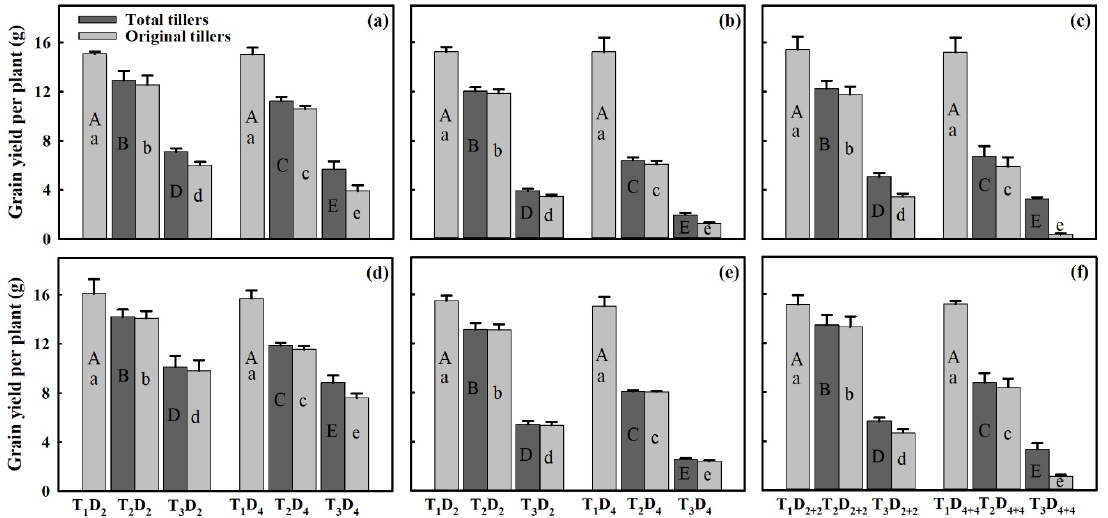
Figure 2. Effects of different high ‐ temperature levels treatments on grain yield per plant including total (original and regenerated tillers) and original tillers of Huaidao ‐ 5 and Wuyunjing ‐ 24 at booting (BT), flowering (FL), and combined (BT + FL) stages. ( a ) Huaidao ‐ 5 at BT treatment; ( b ) Huaidao ‐ 5 at FL treatment; ( c ) Huaidao ‐ 5 at BT + FL treatment; ( d ) Wuyunjing ‐ 24 at BT treatment; ( e ) Wuyun ‐ jing ‐ 24 at FL treatment; ( f ) Wuyunjing ‐ 24 at BT + FL treatment. Different uppercase and lowercase letters indicate significant differences at 0.05 level for total and original tillers, respectively. Vertical bars represent the standard deviation of the mean.